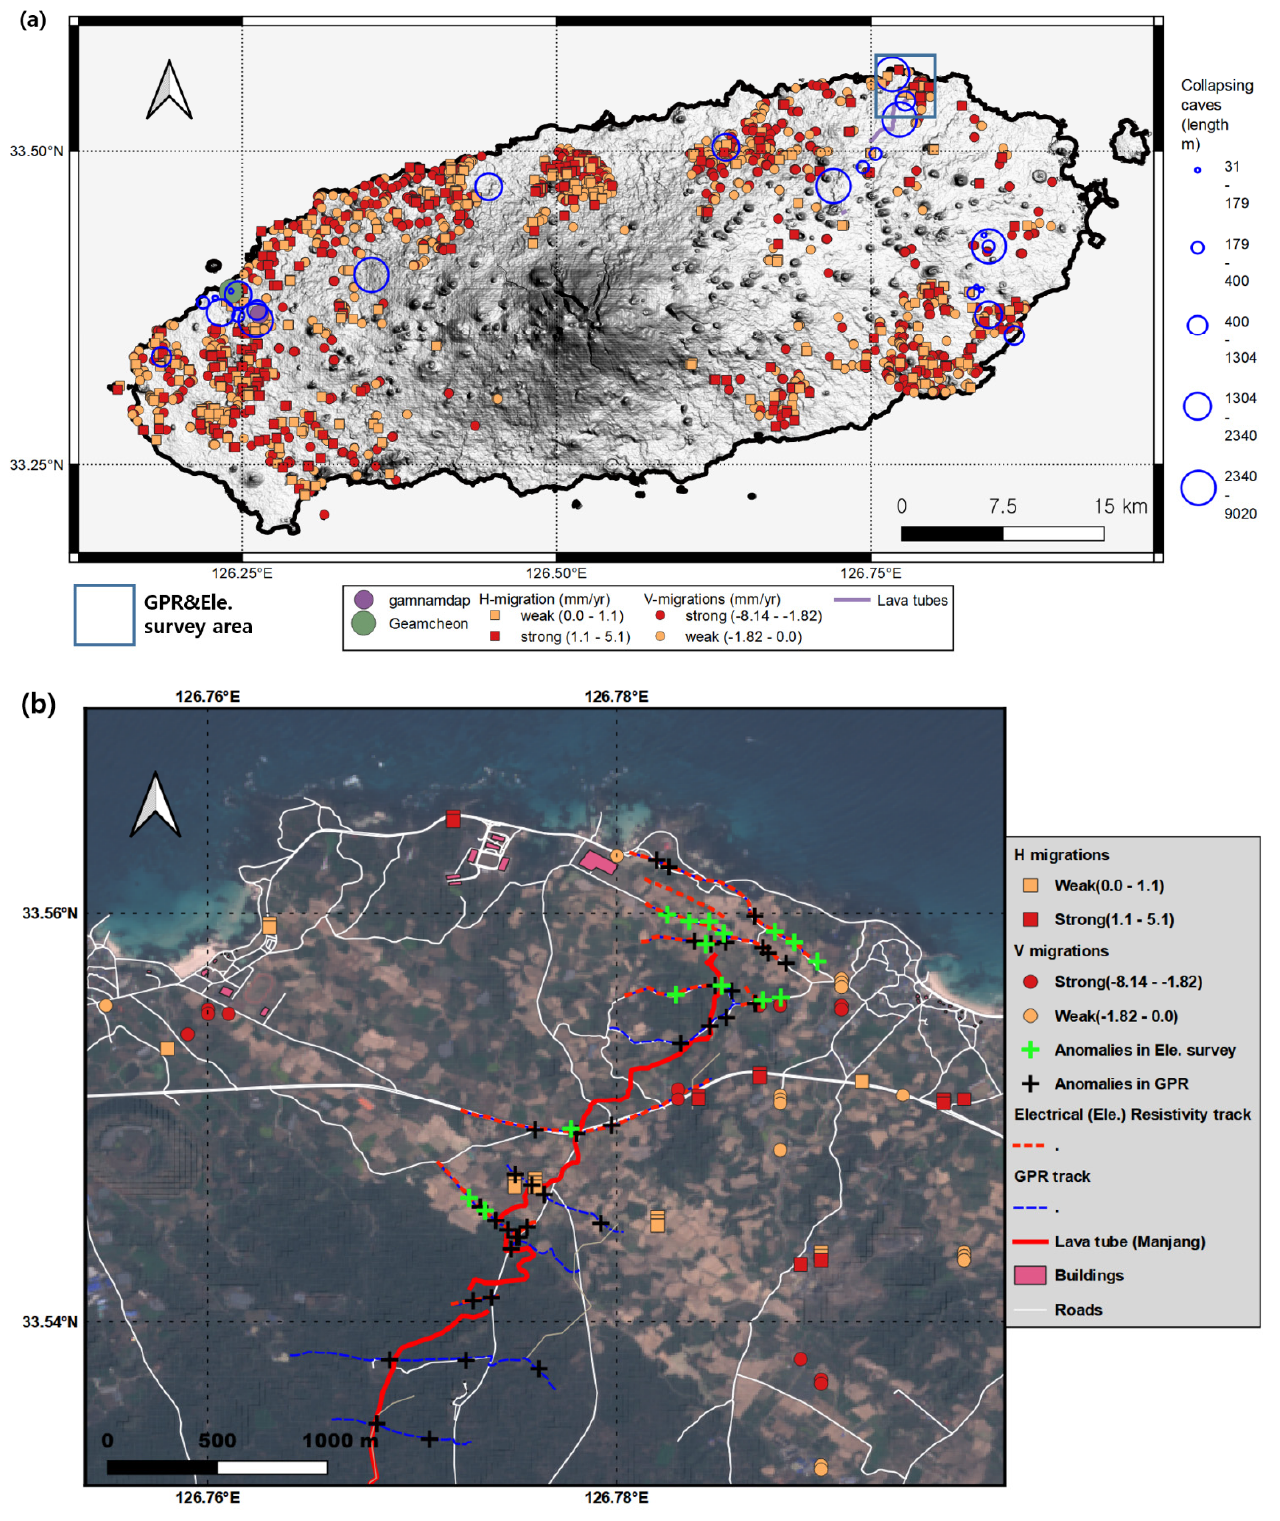
Figure 10. ( a ) The distribution of detected deformations and buffer zones around collapsing lava tubes. Buffer zone was given by the cave length. ( b ) H-V migration points around Manjang cave compared to the GPR and electricity resistivity survey results.